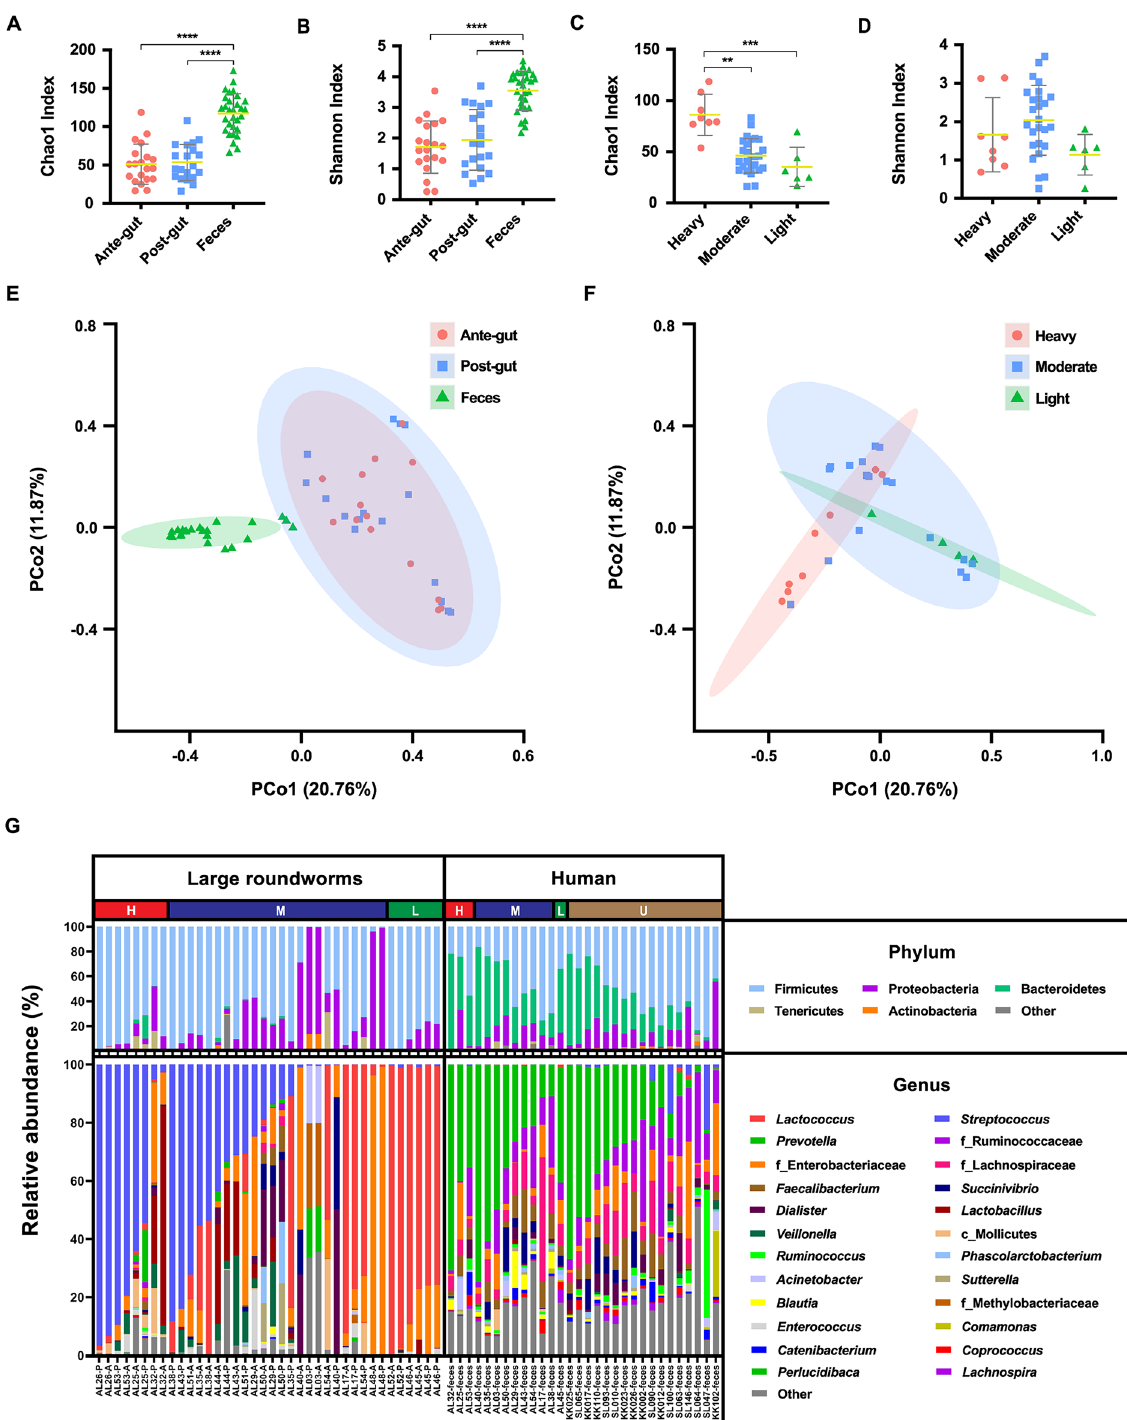
Figure 1. Gut bacteriome diversity and composition in A. lumbricoides and humans. The alpha diversity comparison of bacteriome in ( A , B ) type of samples, and ( C , D ) infection intensity of patients calculated by Chao1 index and Shannon index were shown as scatter plots with the error bars representing the standard deviation and performed statistically significant difference by Kruskal–Wallis test (** P < 0.01, *** P < 0.001, **** P < 0.0001). The beta diversity of bacteriome between ( E ) type of samples and ( F ) infection intensity of patients was presented by principal coordinate analysis (PCoA) plots based on Bray–Curtis distance. ( G ) The stacked plot showed relative abundances of gut bacteriome at the phylum and genus levels in the infection intensity of patients (H = heavy infected, M = moderate infected, L = light infected and U = uninfected) assessed by high throughput sequencing on the 16S rRNA